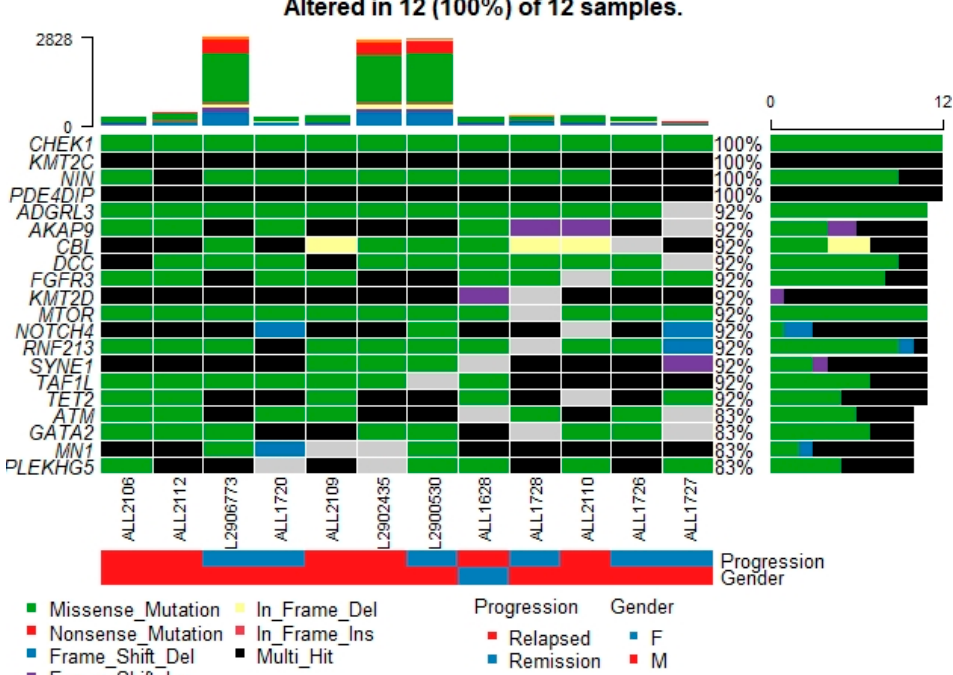
Figure 2. An oncoplot showing the heatmap of variant classification for the top 20 genes across 12 B-ALL samples. The X-axis shows different samples and the Y-axis shows thetop 20 genes. CHEK1, KMT2C, NIN, and PDE4DIP genes harbor mutations across all tumor samples (100%) showing their importance in oncogenesis.